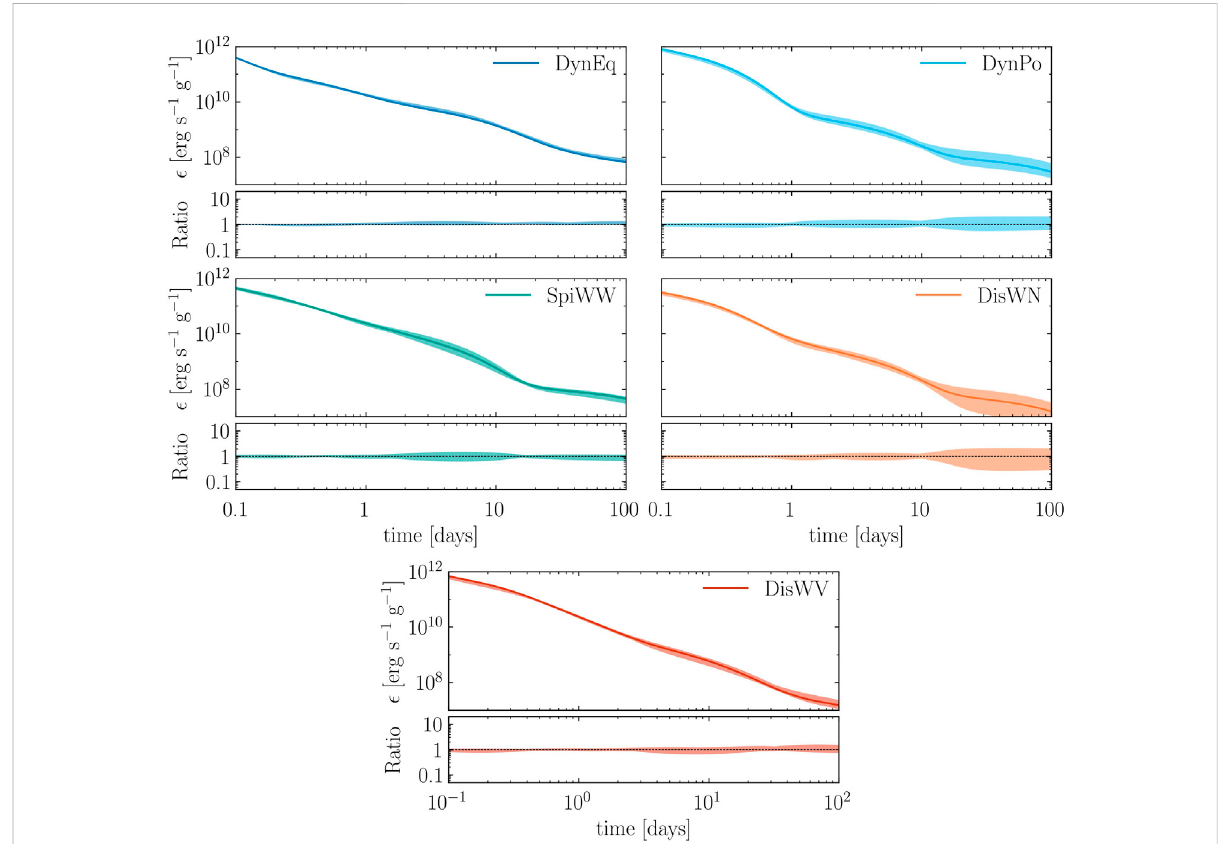
FIGURE 4 Upper panels: Variance in the nuclear heating rate (shaded bands), corresponding to the sensitivity studies for the different chosen trajectories, in the time window 0.1 – 100 days. Lower panels: Ratio of the heating rate with respect to the baseline. Color code as shown in Figure 1.